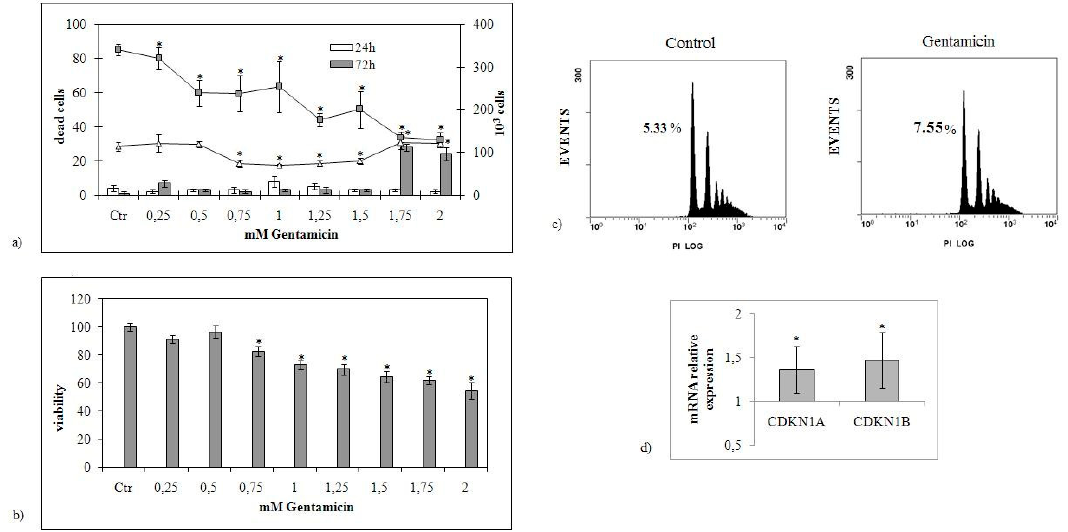
Figure 1. E ff ects of increasing doses of gentamicin on NCI-N87 cells. ( a ) The cells were counted 24 and 72 h after treatment with increasing concentrations of the drug (0.25–2.0 mM) (lines referred to the ordinate on the right). Cell death was evaluated by trypan blue staining (histograms referred to the ordinate on the left). Ctr, untreated sample. ( b ) Cell viability was assessed by MTT method and expressed as a percentage relative to that of the control cells set at 100%. ( c ) FACS analysis. ( d ) CDKN1A, CDKN1B gene expression, data are referred to the gentamicin (GM)-untreated sample (control) set at 1. GAPDH expression was used as a housekeeping gene. RT-PCR analysis was performed in control and experimental NCI-N87 cells collected 24 h after 1.5 mM GM treatment. The data represent the mean ± standard deviation (SD) of three independent experiments performed in duplicate (significance, * p < 0.001 versus control sample).